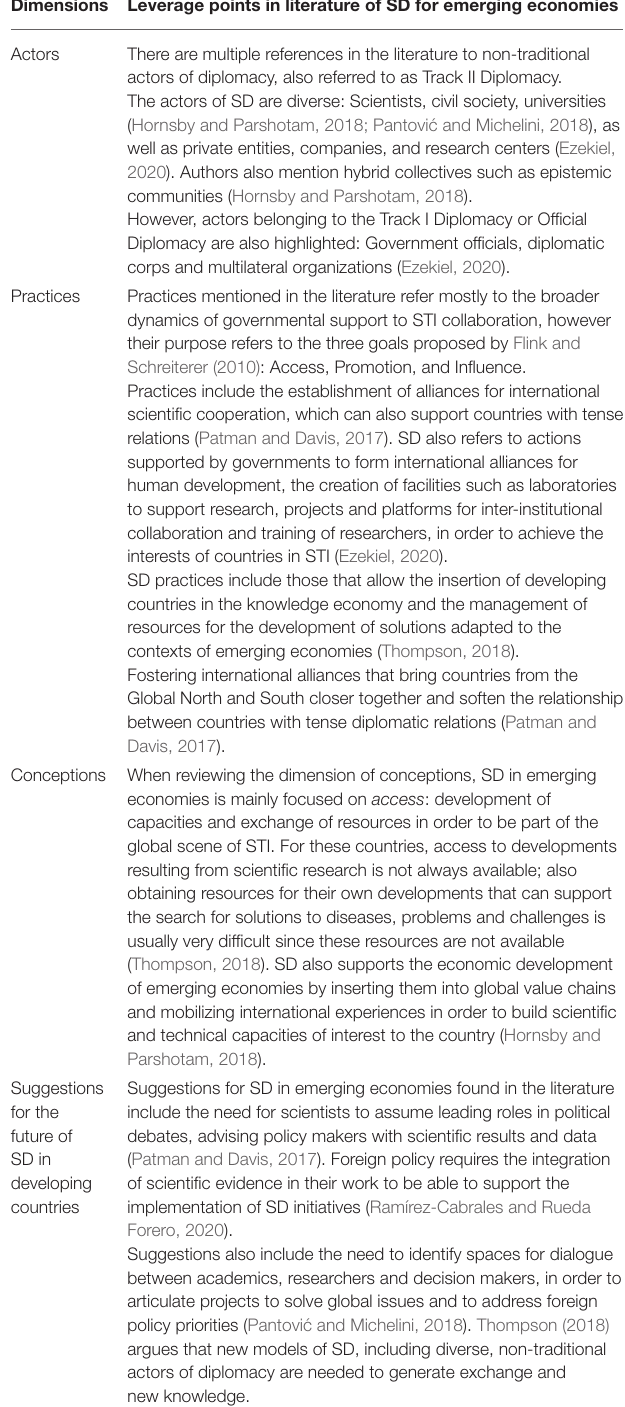
TABLE 1 | References in literature of SD in emerging